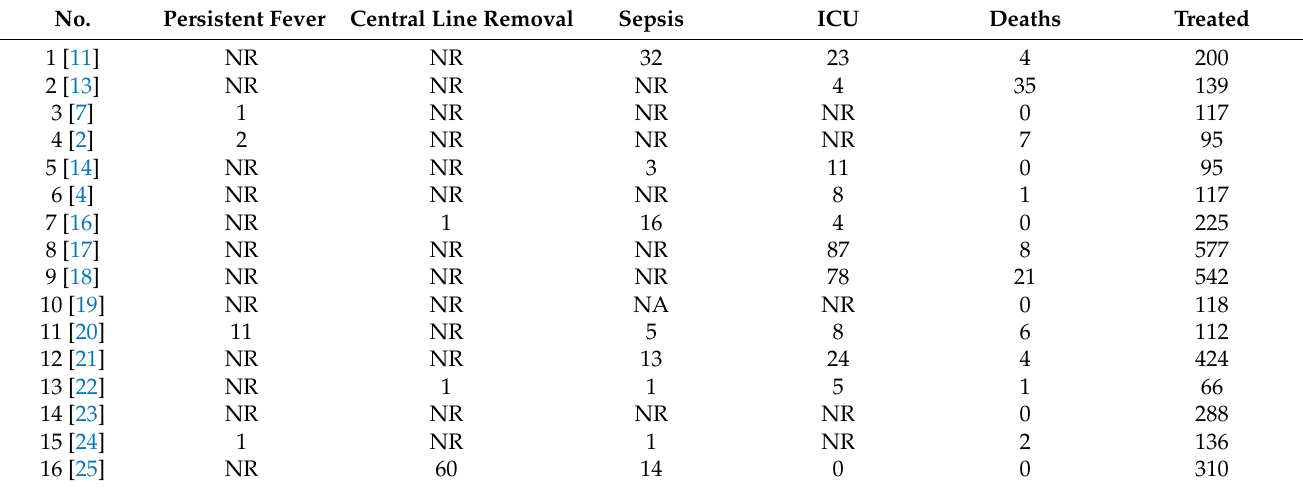
Table 5. Main outcomes as reported from the studied